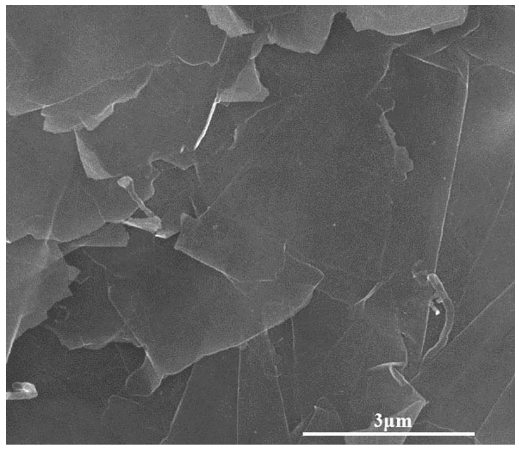
Figure 1. SEM image of the multilayer microstructure morphology of graphene. Table 1. Chemical composition of 2024 aluminum